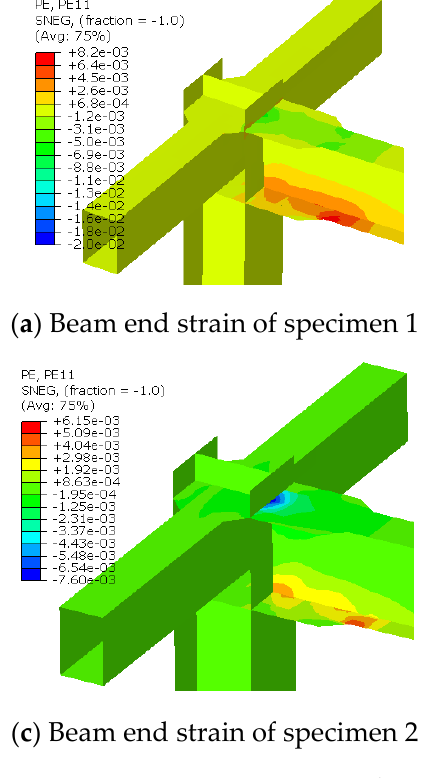
Figure 10. Plastic strain cloud at failure.